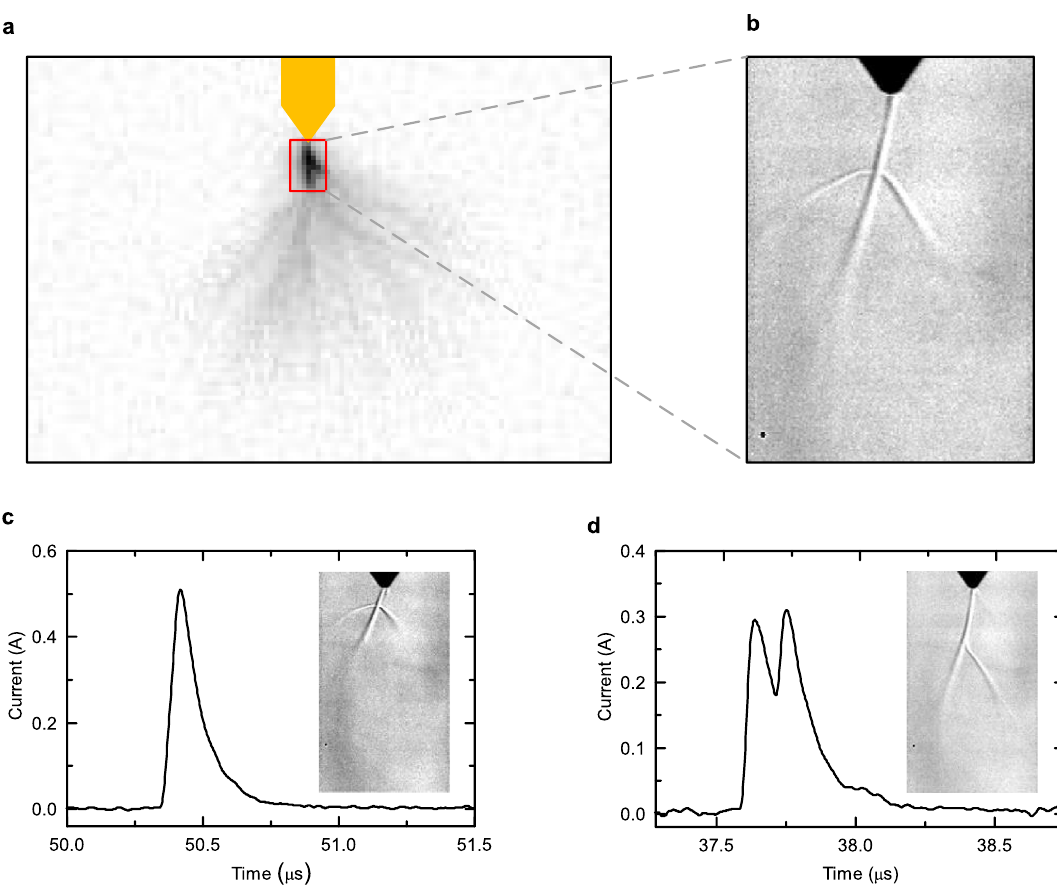
Figure 3. Branching of stems produced by second streamer bursts. ( a ) High-speed photograph of a streamer burst with two distinct filament ensembles. ( b ) Corresponding Schlieren image of the low-density channels branching from a main stem channel. ( c ) and ( d ) show two events with different types of current waveforms measured during stem